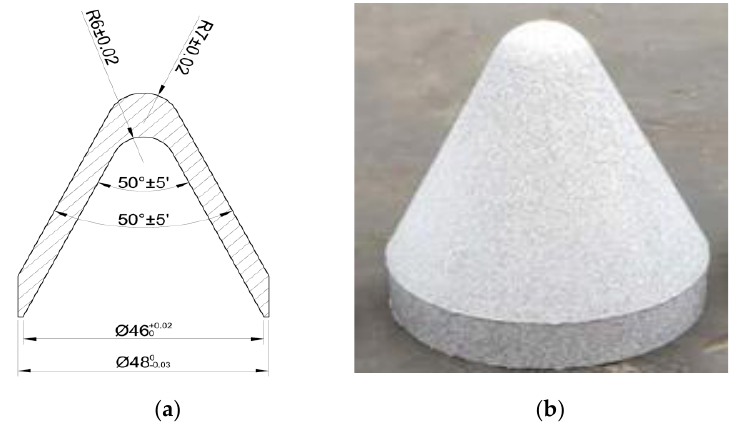
Figure 16. Structure and sample of the reactive liner: ( a ) structure and ( b ) sample.